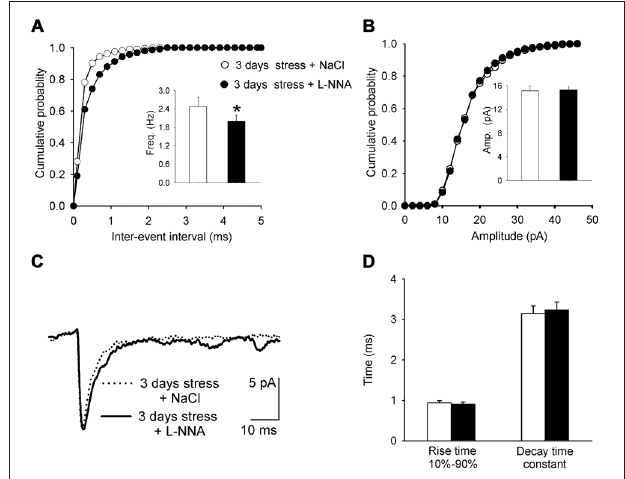
FIGURE 6 | Miniature synaptic currents after restraint repeated over 3 days followed by a 24-h delay before recordings from rats receiving N ω -Nitro-L-arginine (L-NNA) before each restraint session. (A,B) Cumulative probability plots of inter-event interval and amplitude distributions from stressed rats receiving NaCl ( white circles/bars ) and L-NNA ( black circles/bars ). (C) Overlaid average mEPSCs recorded from a control rat receiving NaCl and a rat treated with L-NNA. (D) Comparison of the average ( ± SEM) rise time and decay time constant of mEPSCs in PNCs from stressed rats receiving NaCl ( white bars ) and those receiving L-NNA ( black bars ). ∗ Indicates p < 0.05.